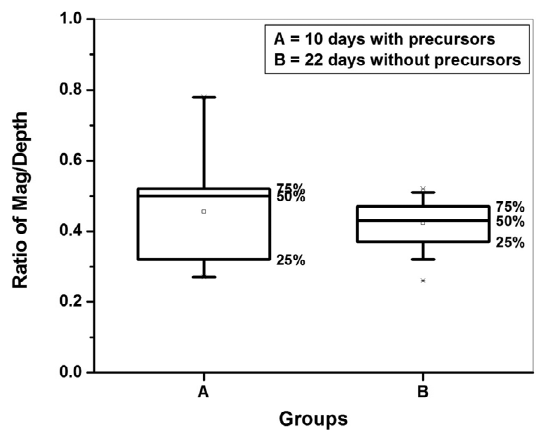
Figure 8. Box plot comparing the 10 days with precursors observed (group A) and the 22 days without precursors observed (group B) with the ratio of earthquake magnitude to depth.